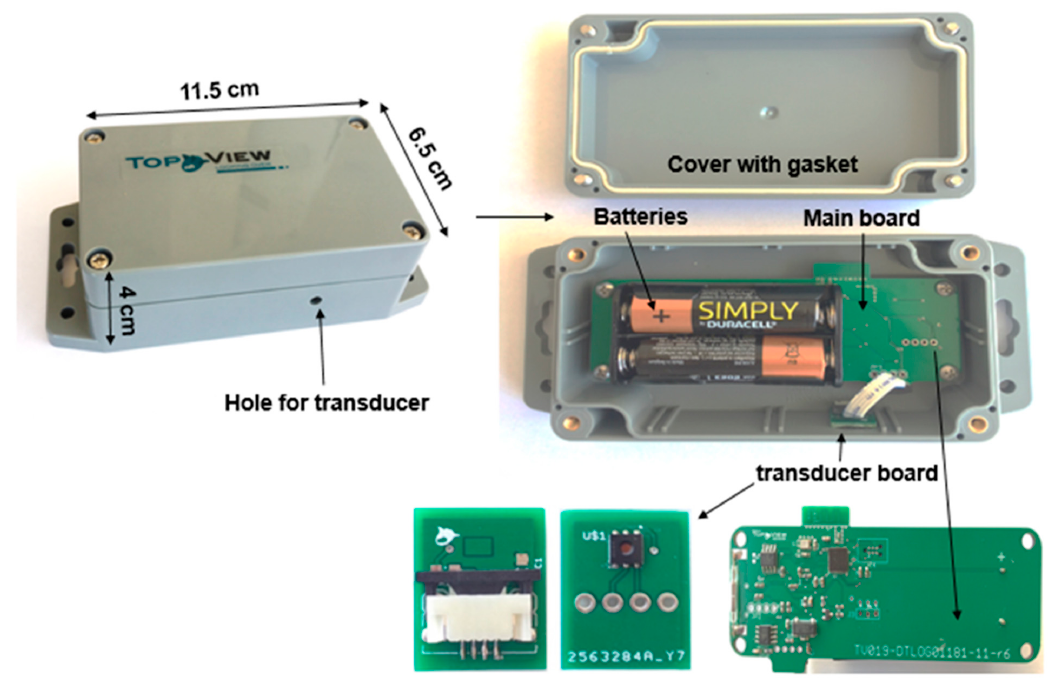
Figure 2. Schematic illustration of the data logger high temperature box (11.5 cm length × 6.5 cm width × 4 cm height × 190 g weight), open and closed with the identification of the inner sealed transducer and its outside hole on the box, along with the main board and the batteries as energy source for active data collection.